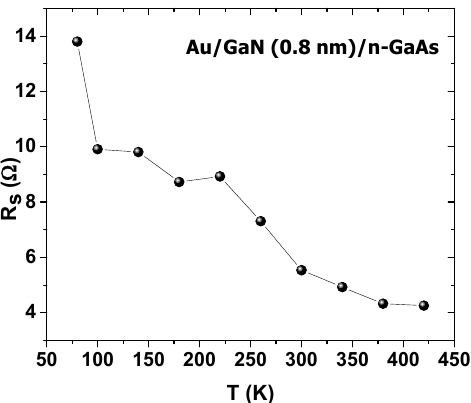
Figure 9. R s (Cheung and Cheung method) versus temperature.